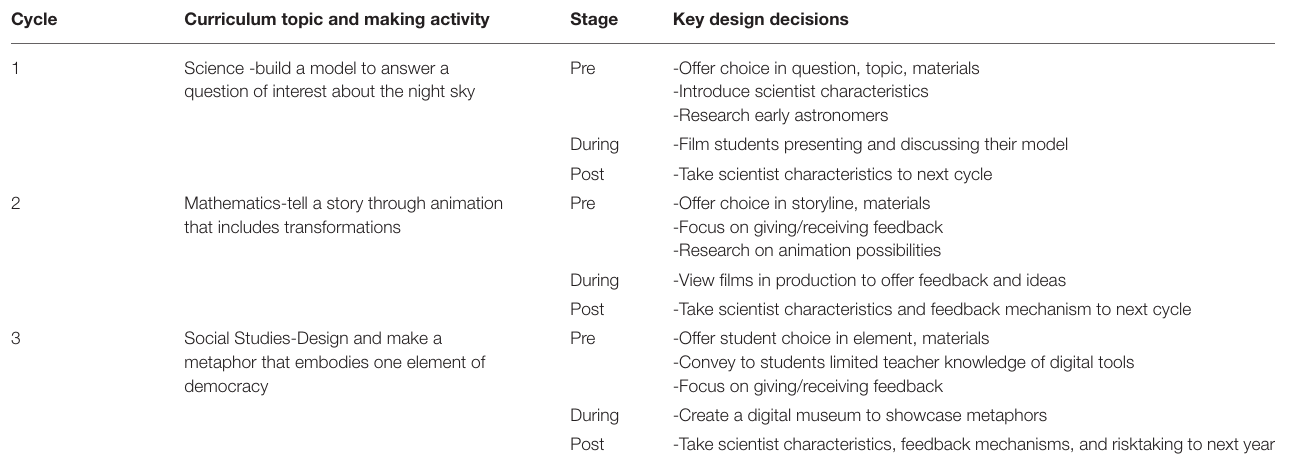
TABLE 5 | Key design decisions and actions enacted during research cycles.